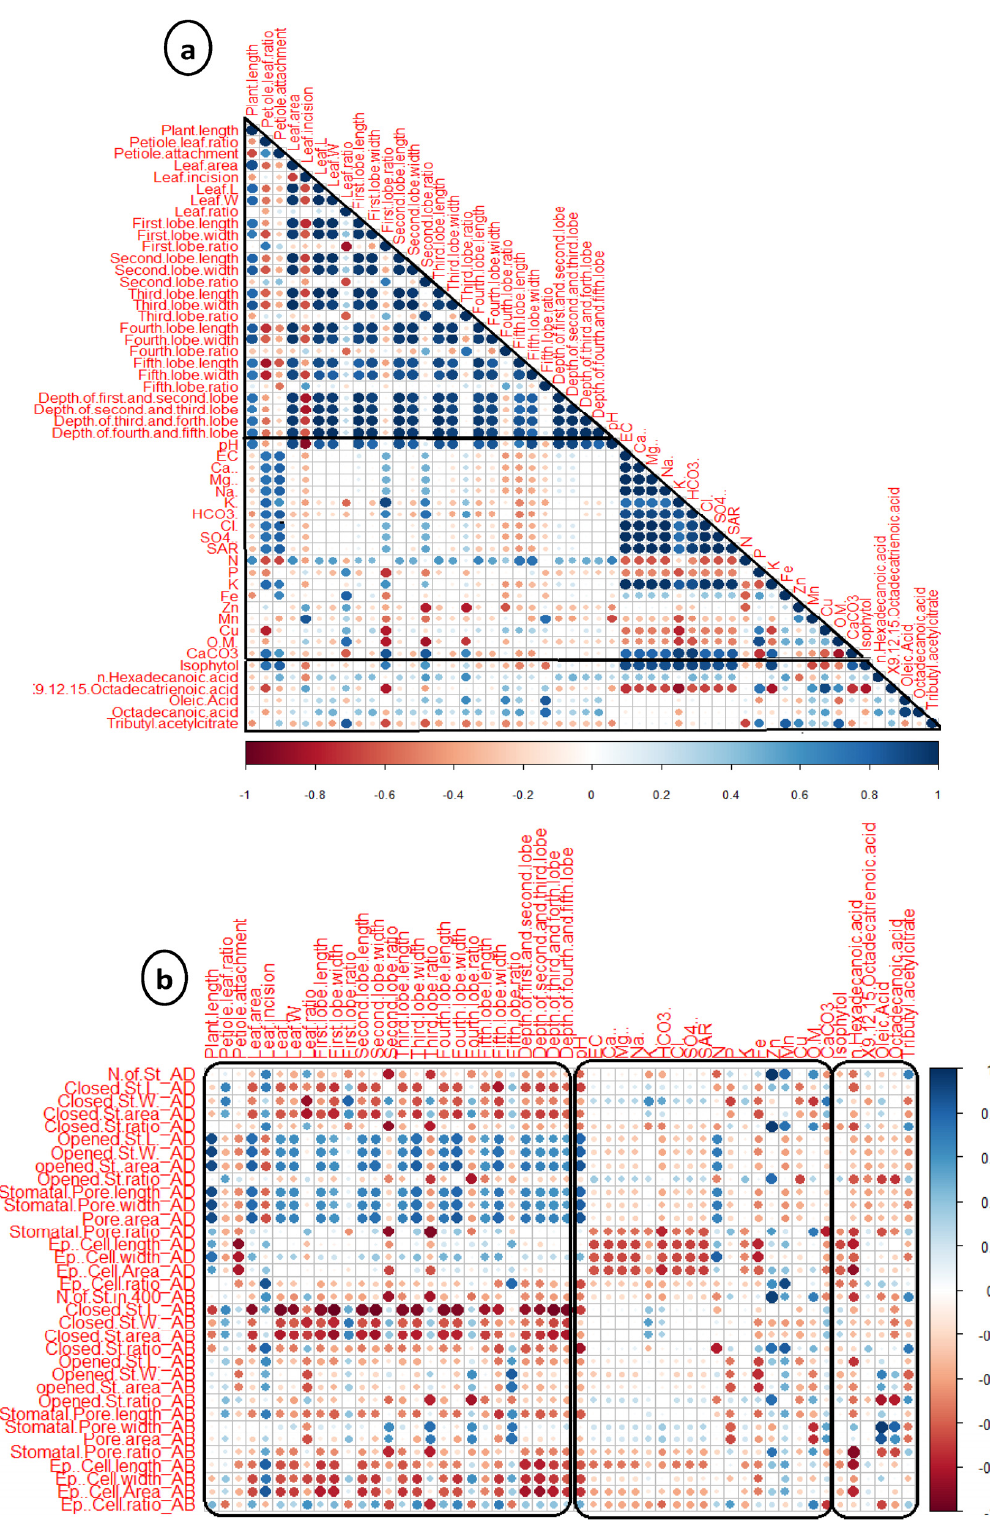
Figure 10. ( a ) Pearson’s correlation analysis based on the correlation coefficients of Ricinus communis traits of vegetative morphometric characters, soil analysis, and chemical composition. ( b ) Pearson’s correlation analysis based on the correlation coefficients of Ricinus communis traits of vegetative morphometric characters, soil analysis, and chemical composition.